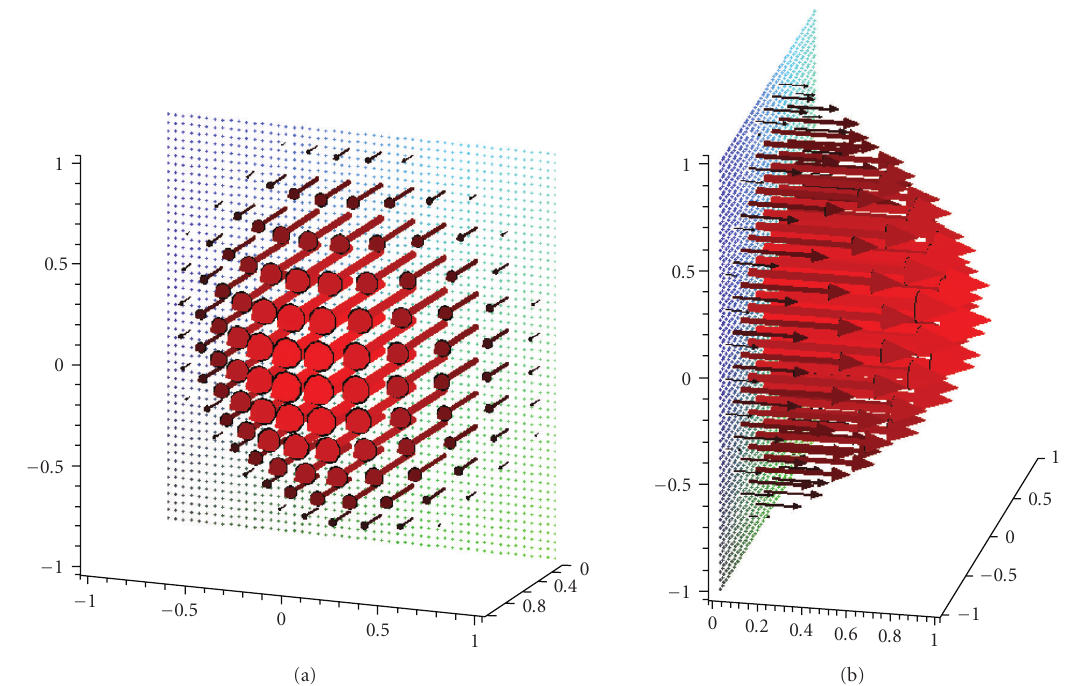
Figure 11: Reconstruction of the vector field f ( x ) = (1 − x 2 2 − x 2 3 ,0,0) (cid:9) with the described algorithm for γ = 0 . 007 in the plane { x 1 = 0 } .